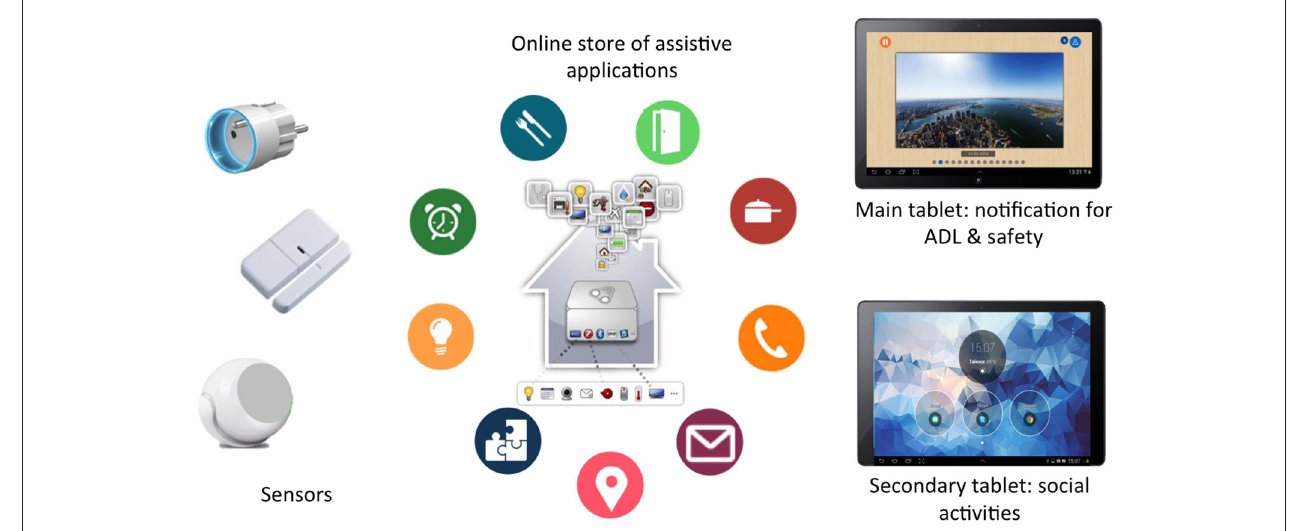
FIGURE 1 | Examples of assistive applications from our online catalog.